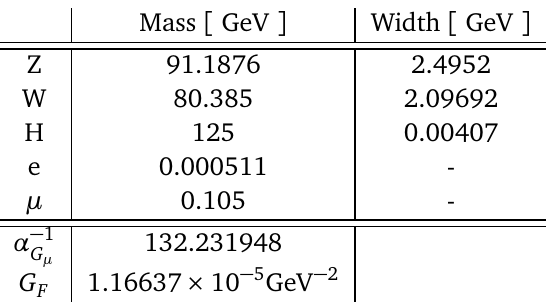
Table 4: List of electroweak parameters in the G µ scheme used for the validation of S HERPA with K ORAL W in e − e + → W − W + production